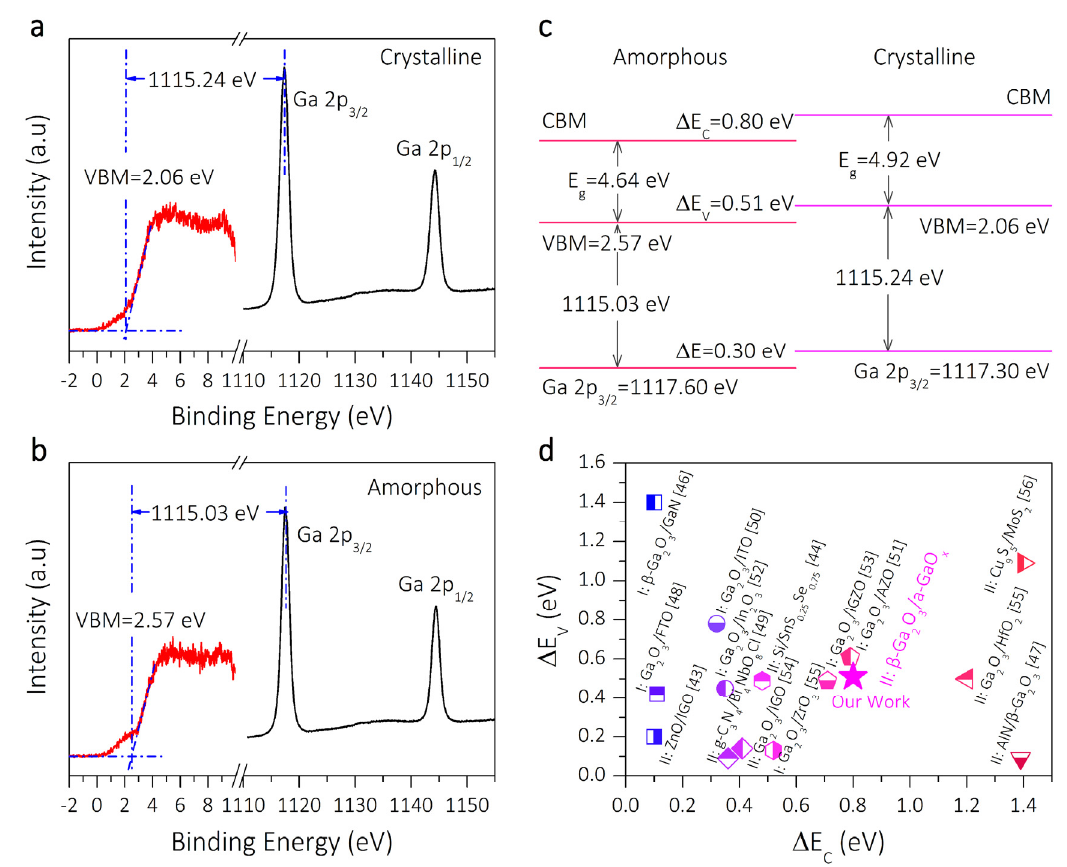
Figure 3. XPS valence band spectra and Ga 2p core level of crystalline ( a ) and amorphous ( b ) Ga 2 O 3 films. ( c ) Schematic illustration of energy band alignment of amorphous/crystalline Ga 2 O 3 . ( d ) Comparison between previously reported conduction and valance band offsets of heterojunction with our amorphous/crystalline Ga 2 O 3 [51,52,54–64].